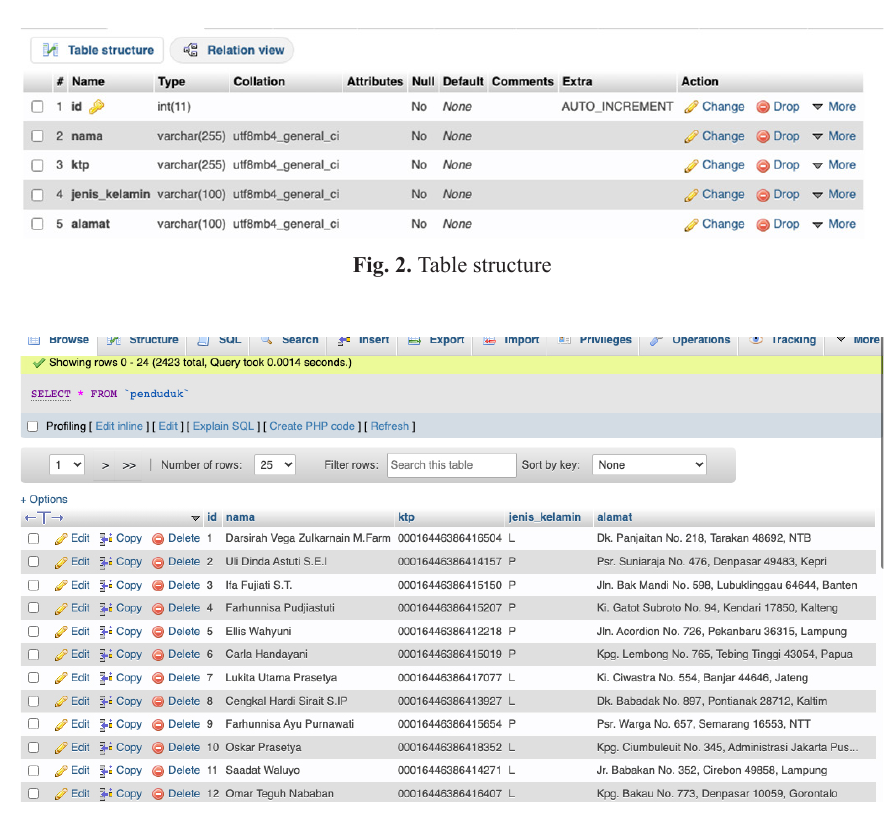
Fig. 3. Example of population